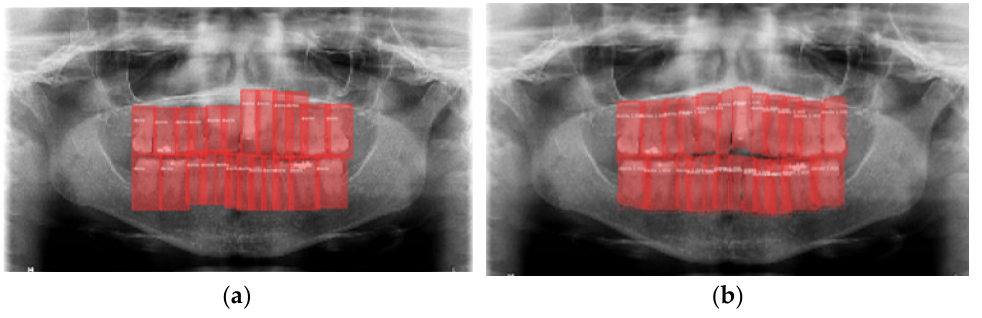
Figure 9. Bounding boxes: ( a ) by experts; ( b ) by the model.